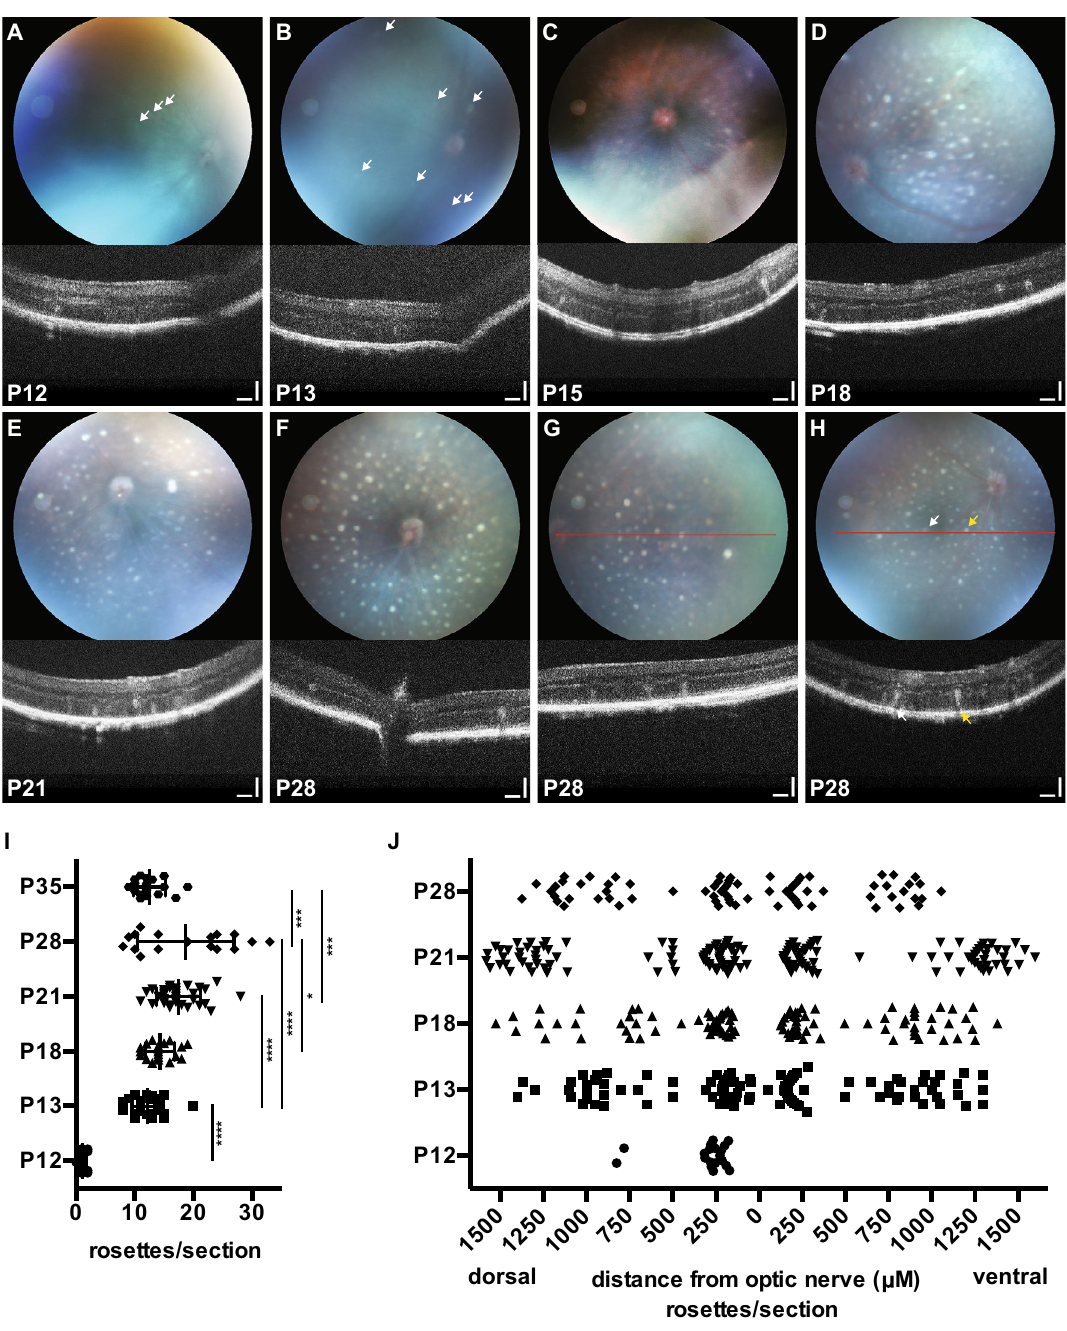
Figure 1. White spots and ‘rosettes’ in early postnatal C57BL/6J Nr2e3 rd7/rd7 retinas. Fundus examination (upper panels) and representative OCT imaging (lower panels) on C57BL/6J Nr2e3 rd7/rd7 eyes at postnatal day (P) 12 ( A ), P13 ( B ), P15 ( C ), P18 ( D ), P21 ( E ) and P28 ( F – H ). At P12 and P13 white spots are indicated by white arrows because retinal imaging is hampered by the developmental opacity of the lens ( A , B ). At P28, the region of the OCT section is indicated by a red line ( G , H ), and colocalization of white spots and ‘rosettes’ indicated by color-coded arrows ( H ). Scale bars: 50 µM. ( I ) Quantification of ‘rosettes’ in histological sections of C57BL/6J Nr2e3 rd7/rd7 retinas during postnatal development. Three retinas from three different mice were analyzed. Per retina, the number of ‘rosettes’ was counted on five hematoxylin–eosin stained sections along a dorso- ventral axis containing the optic nerve head. Statistical analysis was performed by ordinary one-way ANOVA with Tukey’s multiple comparisons test. *p < 0.05 ***p < 0.001; ****p < 0.0001. ( J ) Qualitative spatio-temporal distribution of rosettes analyzed in graph I along a dorso-ventral axis relative to the optic nerve head